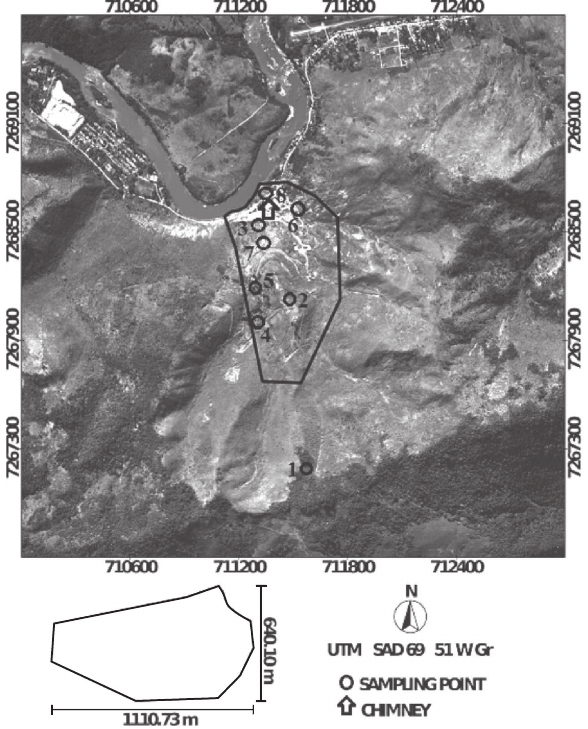
Figure 1. Georeferenced aerial photo of the study area under direct influence of Pb mining and metallurgy (the abandoned factory is located close to the Ribeira river), in Adrianópolis (PR), Brazil. The most contaminated central area (49.8 ha) is marked by the contour